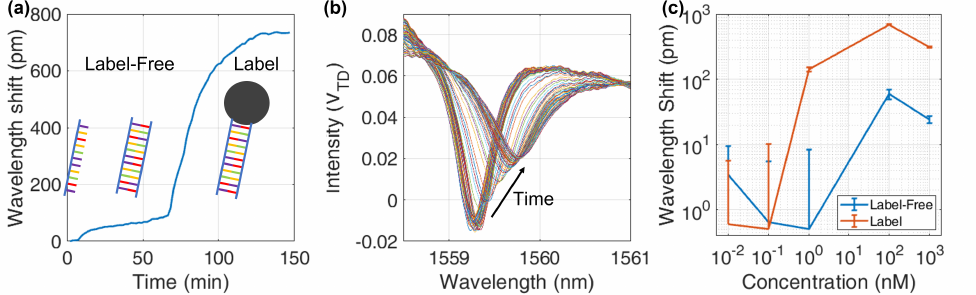
Figure 5. Measured effects of the hybridization: ( a ) Resonance shift difference between functionalized and control MRRs in case of funtionalized, unlabel and labelled detection (100n M concentration). ( b ) Collection of MRR spectral responses acquired from the sensing MRR at 100n M during the binding: the ring resonance shifts and the Q − factor reduces. ( c ) Wavelength shifts at different concentrations for label − free and labelled bindings. Labelled shifts are at least ten times larger than label −